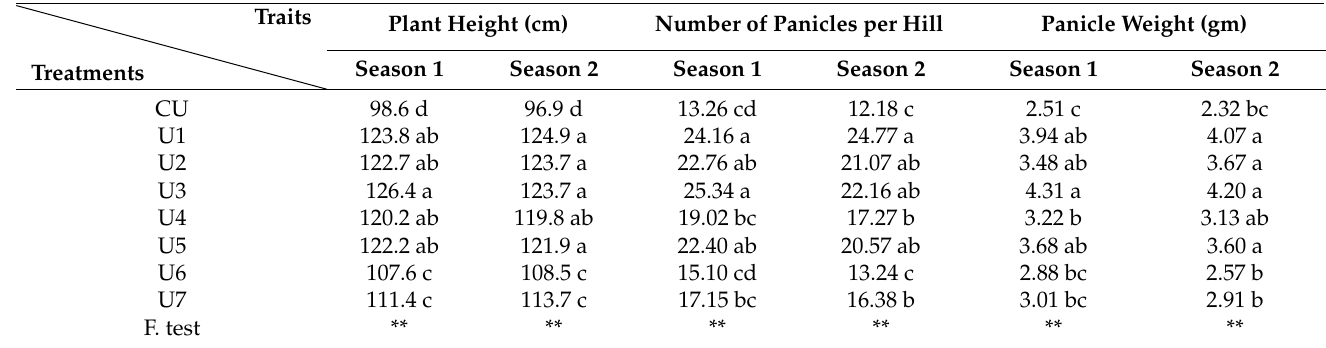
Table 5. Effects of different rates of classical urea fertilizer, urea chitosan nanohybrid and their combinations as exogenous application on plant height, number of panicles/hill, and panicle weight of rice plants during the 2020 and 2021 seasons.